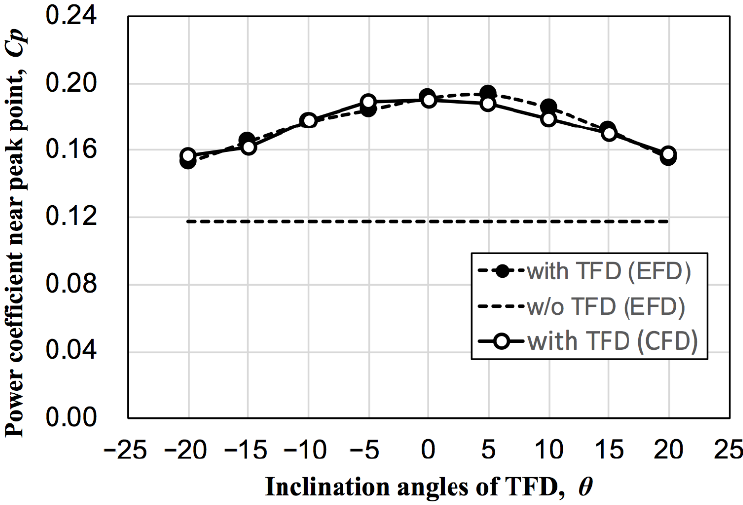
Figure 13. Relation between power coefficient Cp near peak point and inclination angles of three flow deflectors θ by CFD comparing with EFD results (maximum power coefficient, Cp max ).